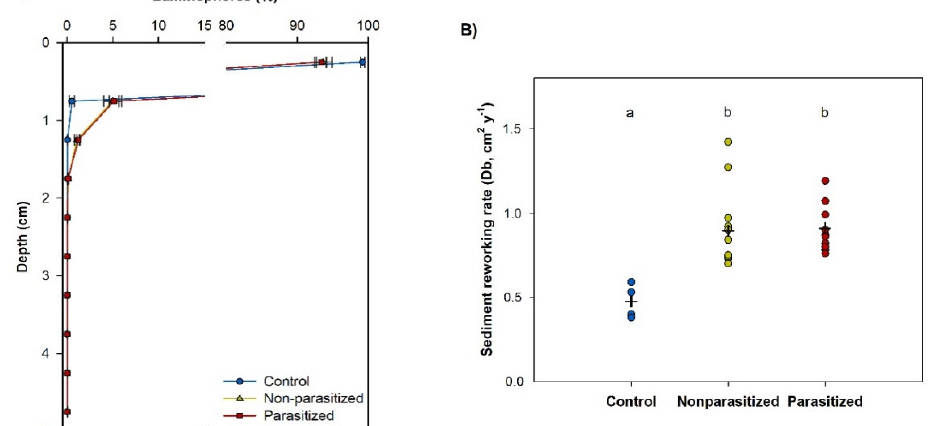
Figure 2. ( A ) Depth profiles of luminophores initially deposed at the surface of experimental units (mean ± SE), and ( B ) sediment reworking rate (Db) (data are represented by points; black crosses correspond to the mean value) following nine days of incubation for the three treatments (“control” ( n = 4), “nonparasitized” ( n = 12), and “parasitized” ( n = 12)). Different letters indicate significant differences among treatments ( p < 0.05) after performing a pairwise t -test with Bonferroni correction when one-way ANOVA was significant ( p <